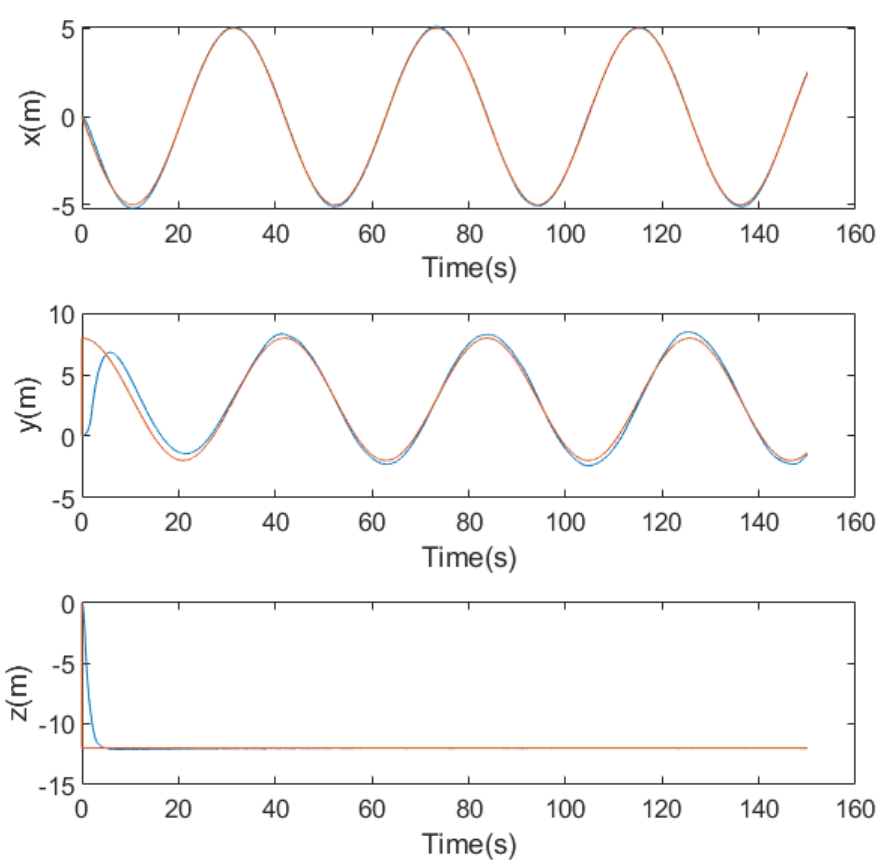
Figure 13. Bias fault: the position control performance (red line–desired, blue line–actual).